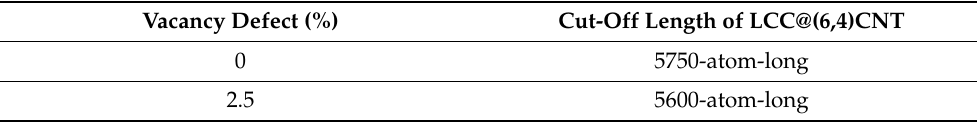
Table 3. The effect of vacancy defects on the stability of the LCC@(6,4)CNT at 300 K.